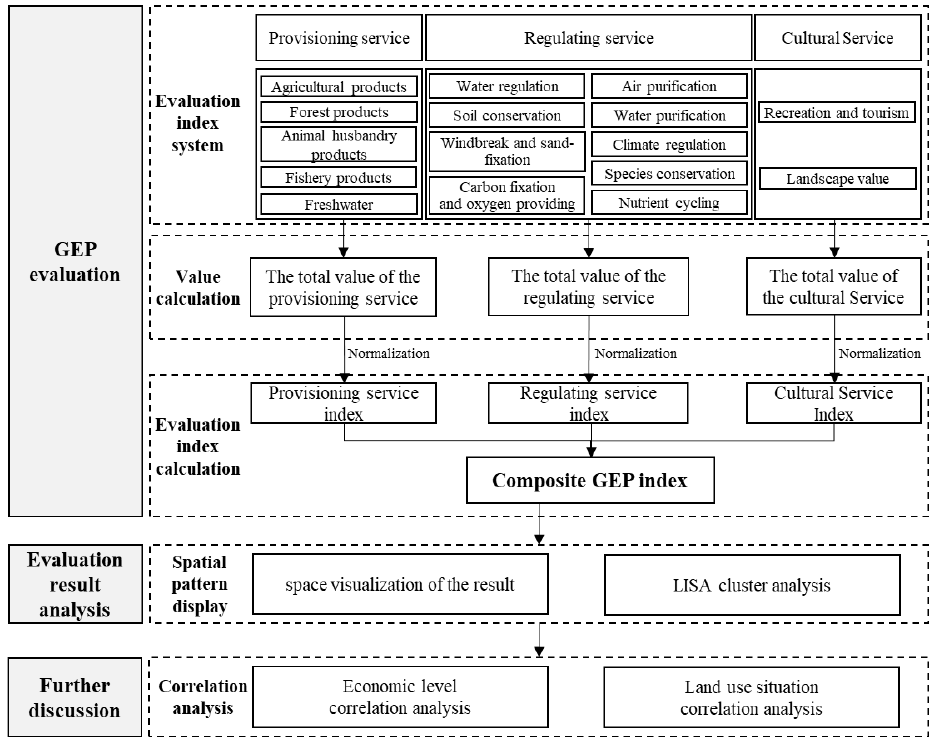
Figure 2. Technology